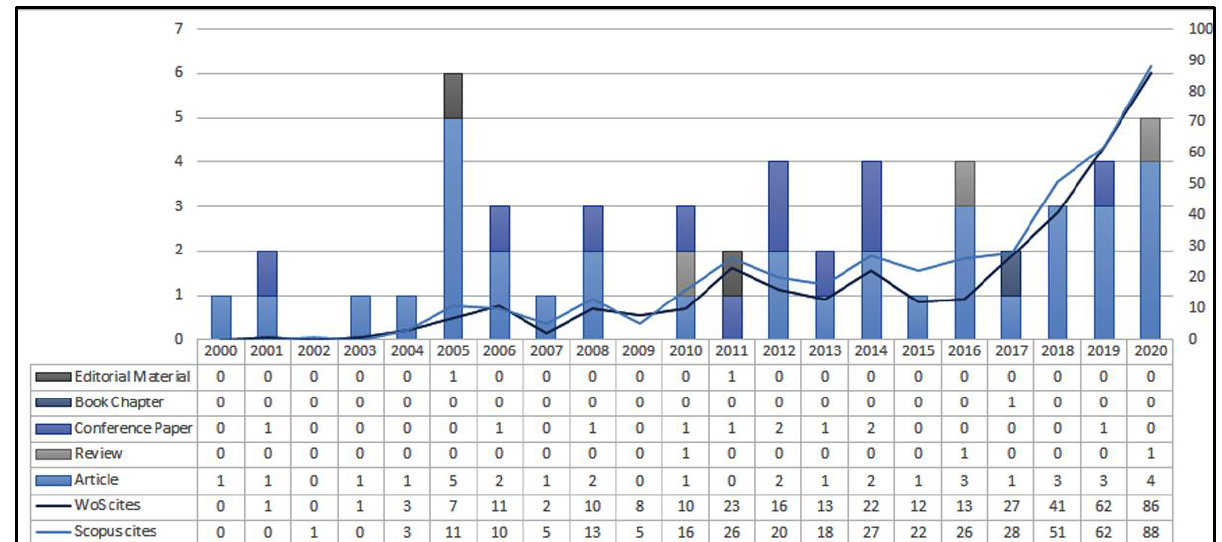
Figure 1. Annual distribution of papers and the evolution cites from 2000 to 2020.